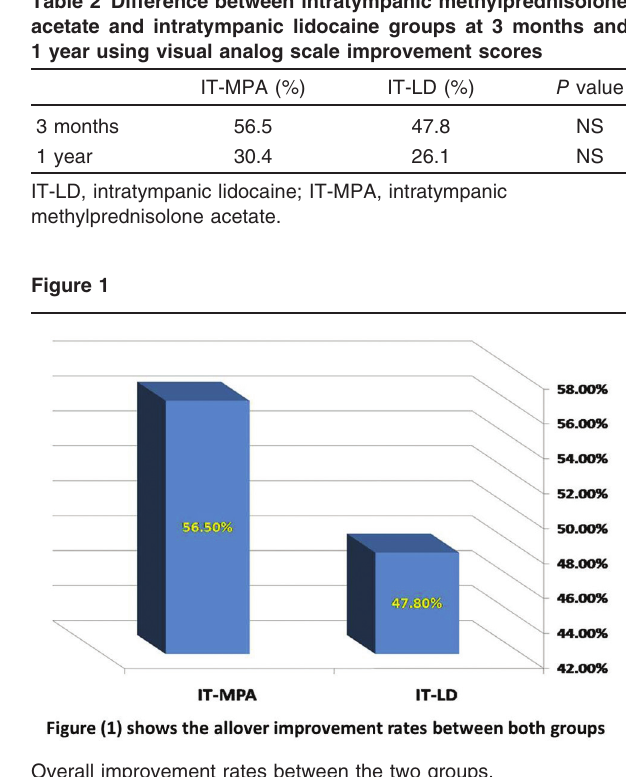
Overall improvement rates between the two